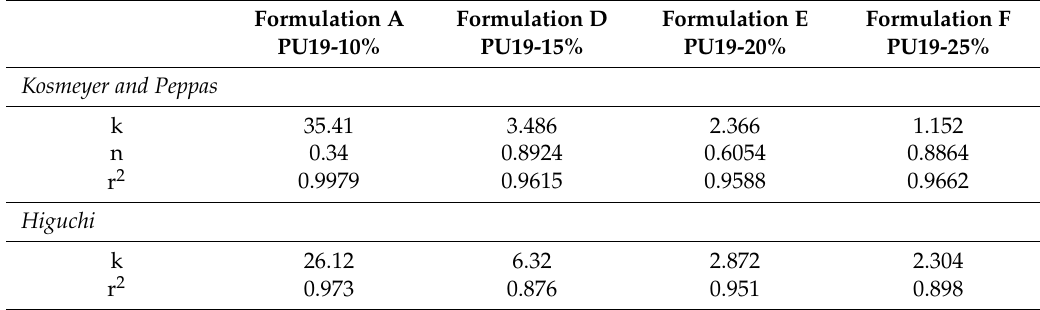
Table 2. Fitting results of TH release profiles to Kosmeyer and Peppas [24] and Higuchi [25] kinetics.